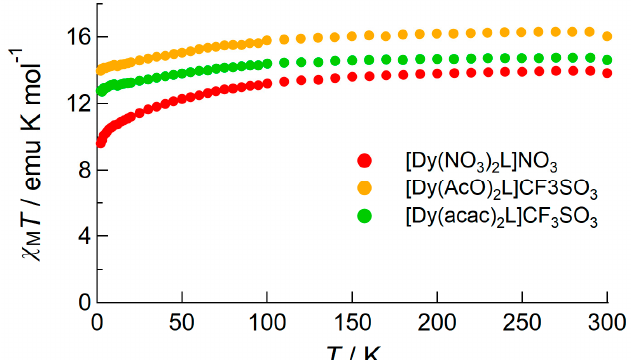
Figure 3. Temperature dependence of the χ M T product for each complex measured under a 1000 Oe DC field applied DC field applied condition.